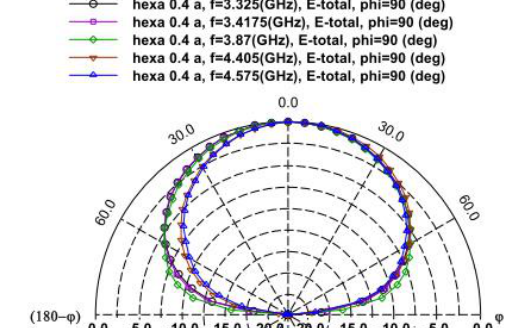
Figure 11. Variation of two-dimensional elevation patterns at (a) 3.29 and (b) 4.24 GHz.